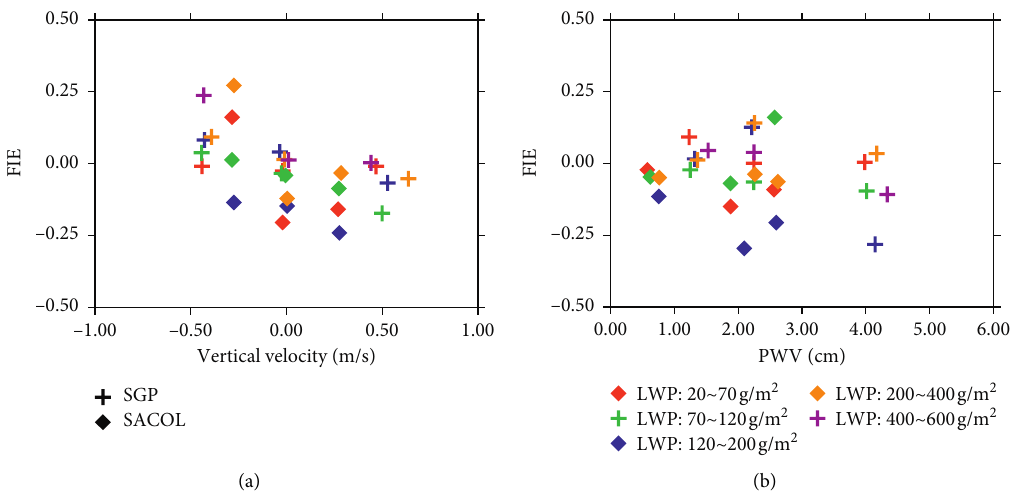
Figure 6: Relationship between the aerosol first indirect effect index, that is, the slope of the linear relationship between cloud droplet effective radius ( r e ) and condensation nuclei concentration number (CN), and (a) vertical velocity and (b) precipitable water vapor (PWV) at the SGP (plus signs) and SACOL (squares) sites. Data are binned according to